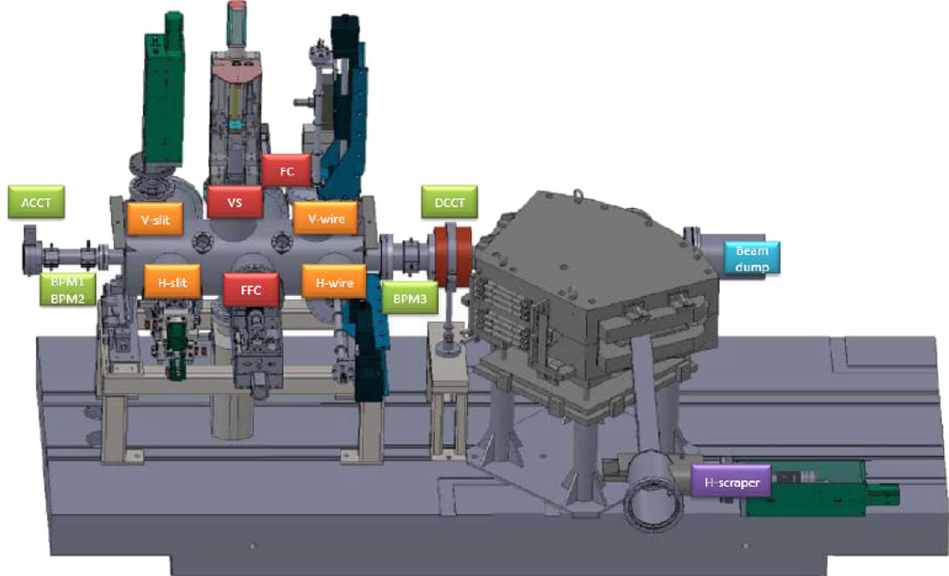
FIG. 5. Movable beam measuring